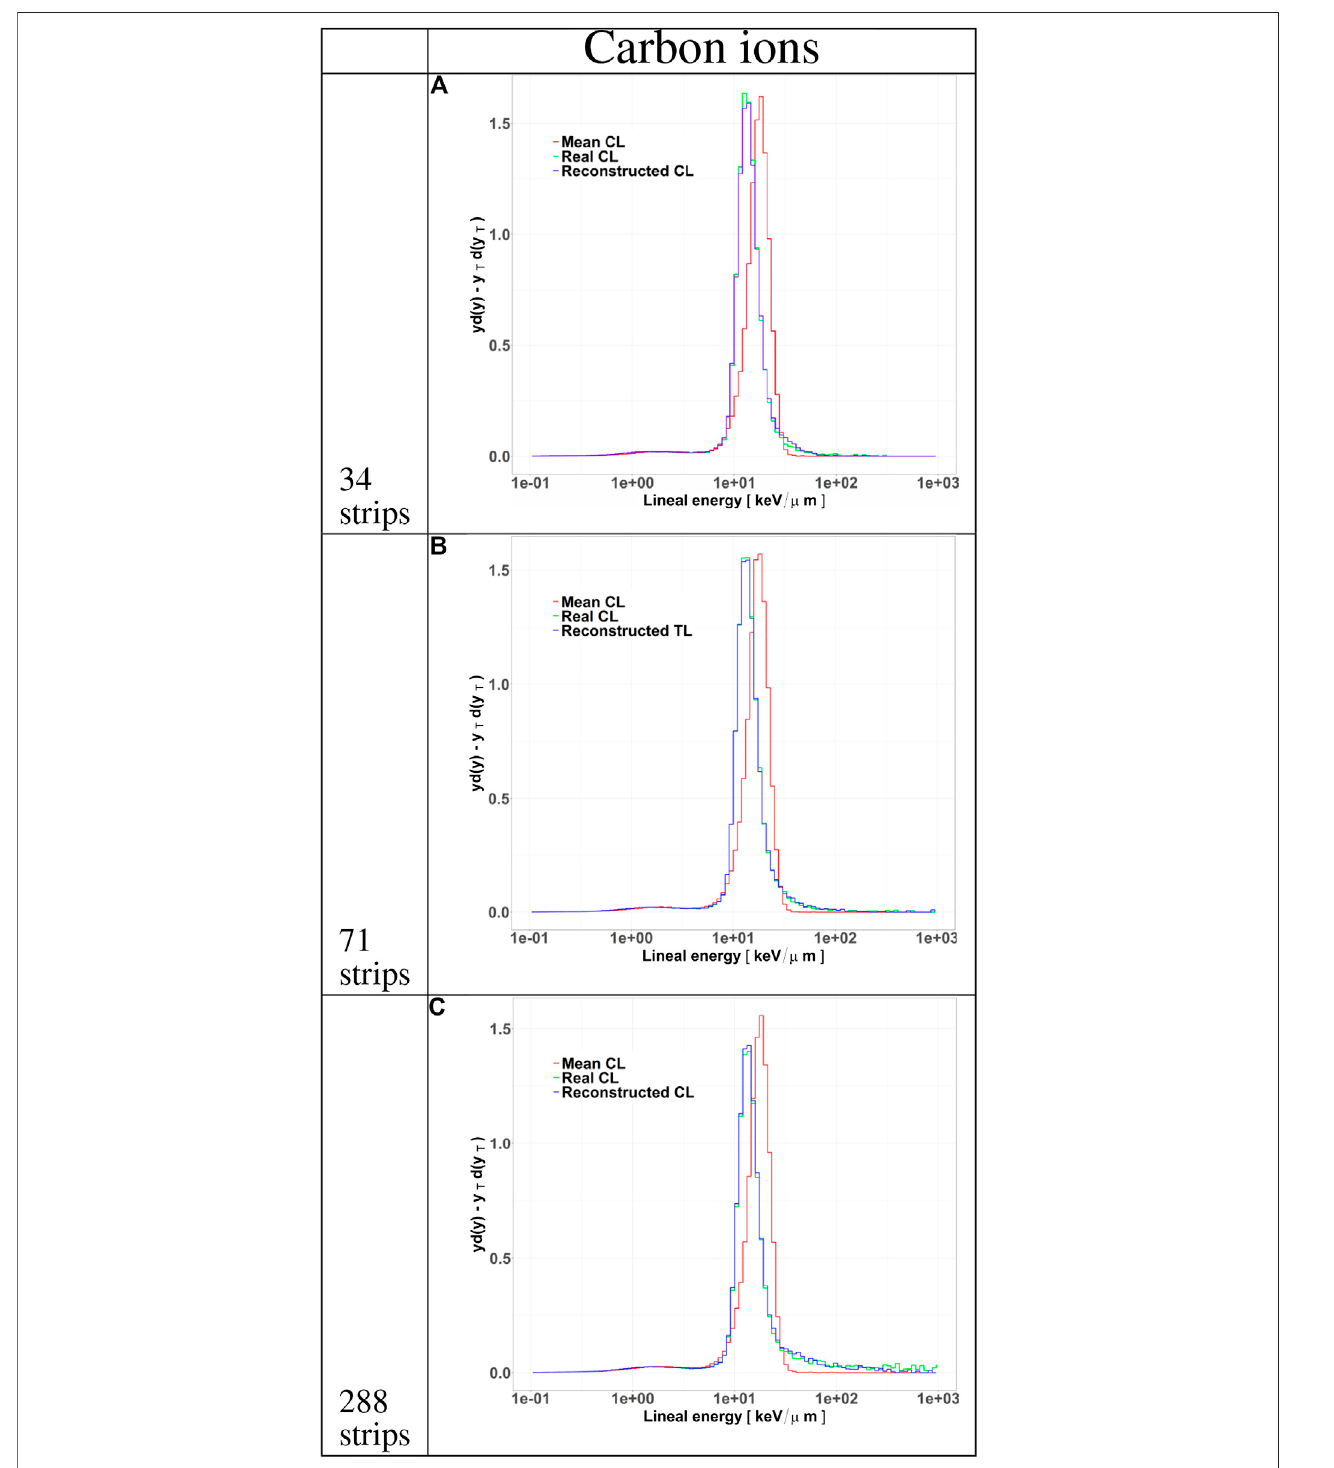
FIGURE8| Microdosimetric spectraofallparticlestrackedbyHDMwhenirradiatedwith290 MeV/ucarbonionsatadepthof10.74 cminwater.Thedistributions include the standard yd ( y ) spectra calculated with the mean chord length (red line) and the Y T d(Y T ) spectra obtained either with the real track length (green line) or with the value estimated with the tracking algorithm (blue line). The distributions are shown for LGAD con fi gurations with 34 (A) , 71 (B) , and 288 (C) strips.